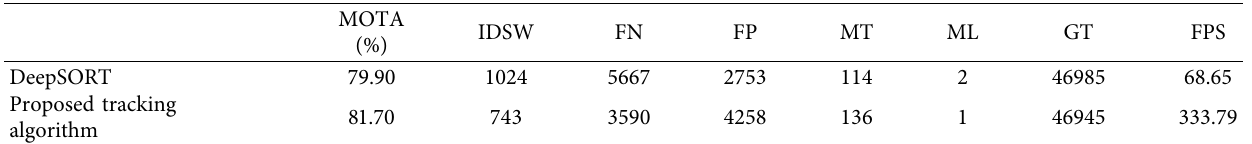
Figure 3: Detection performance improvement: (a) before and (b) after additional training. After additional training, the model detects a pedestrian carrying umbrella and distinguishes a personal mobility device from a pedestrian. Table 2: Object-tracking performance